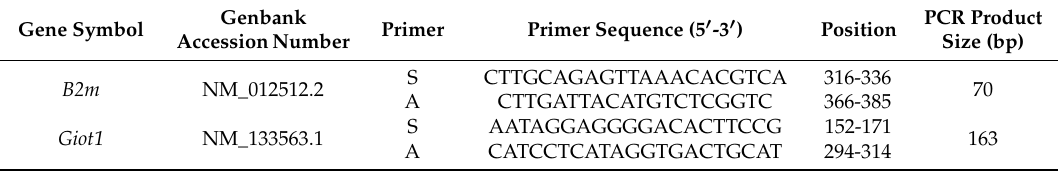
Table 1. Primers used for qPCR validation of Giot1 gene. B2m (beta-2 microglobulin) was the reference